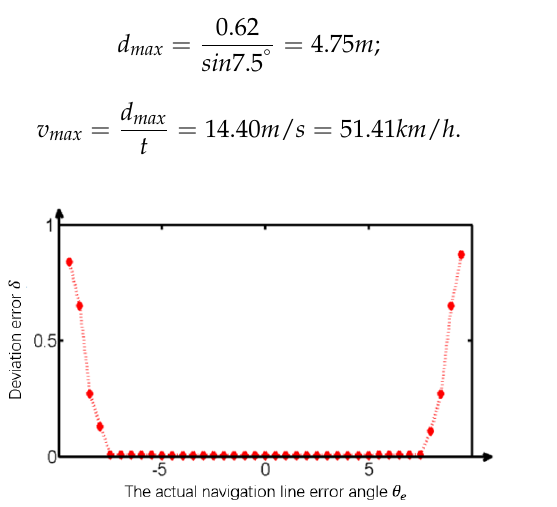
Figure 20. Error research.